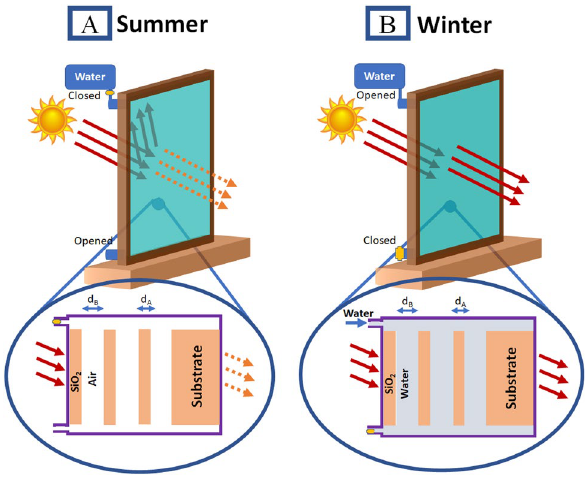
Figure 1. Schematic diagram of proposed smart windows ( A ) in summer, visible electromagnetic waves will be transmitted and IR will be blocked, ( B ) in winter, visible and IR electromagnetic waves will be